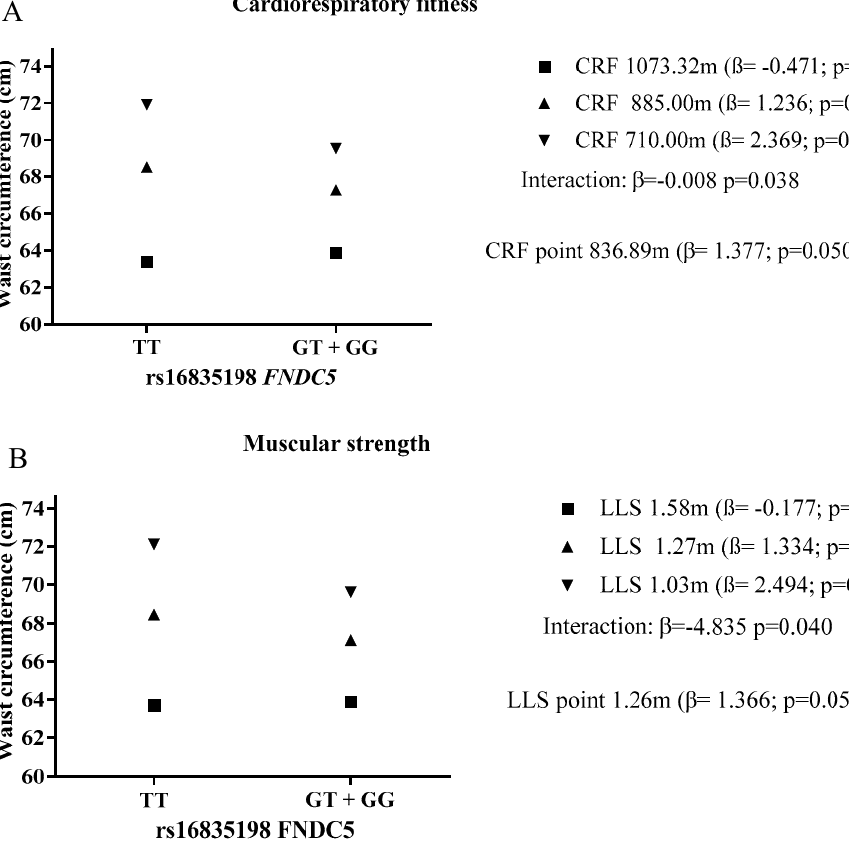
Figure 1. The role of cardiorespiratory fitness level ( A ) and muscular strength level ( B ) in the relationship between rs16835198 FNDC5 and waist circumference. CRF: Cardiorespiratory fitness; LLS: Lower limb strength. All analyses were adjusted for age, sex, skin color, living area, and school